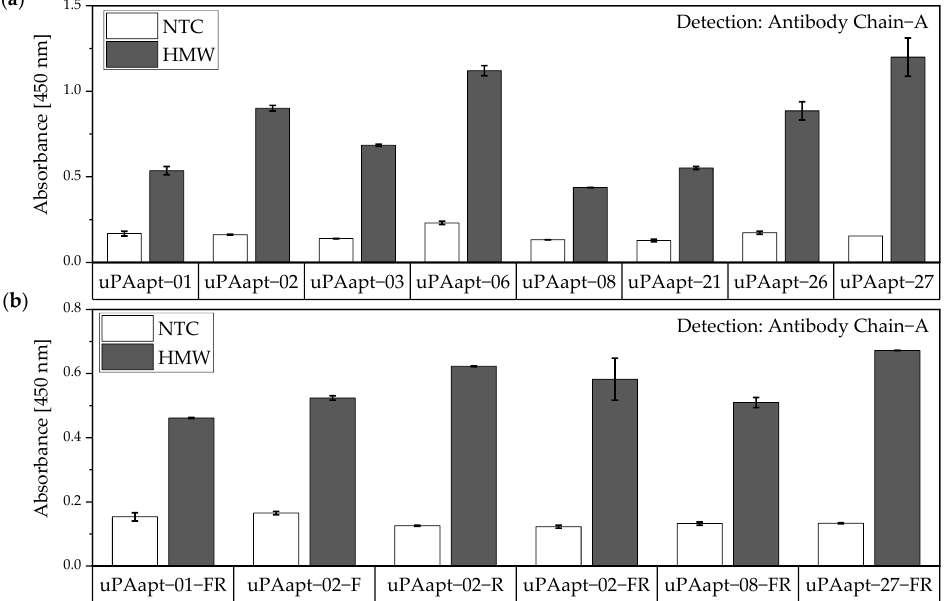
Figure 8. Aptamer–Antibody-based sandwich assay for detection of HMW-uPA by Antibody Chain A (Ab Chain A). HMW-uPA could be detected using ( a ) all uPA aptamers and ( b ) several of the truncated variants as capture aptamers when Ab Chain A is used as a reporter molecule, which only detects the HMW-uPA form due to binding to the A-chain of uPA. The absorbance for each sample is given as the mean value of technical replicates. Error bars represent the range of measured values. Number of records n = 2.